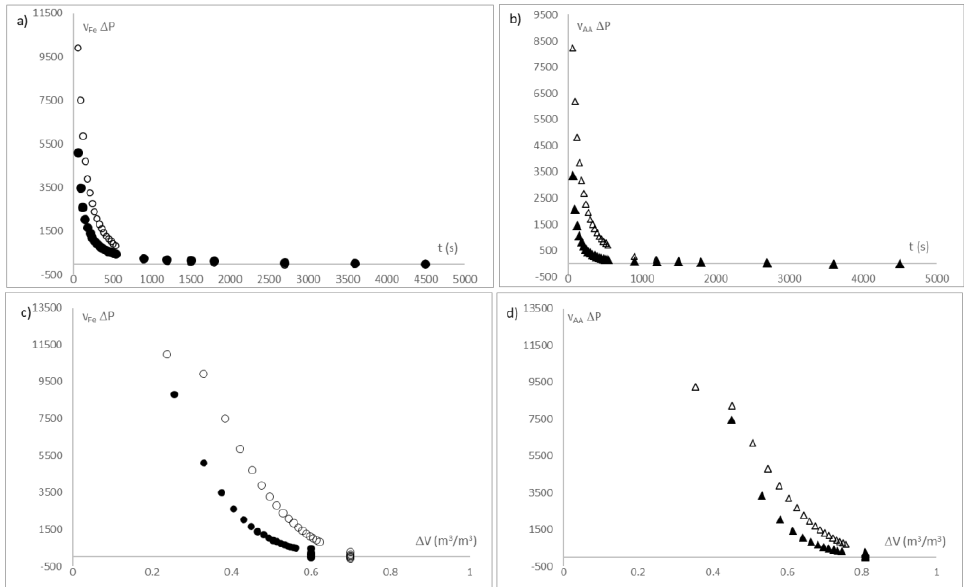
Figure 13. ( a , b ) represents the evolution of the mechanical gradient of ( a ) the iron ion beads and ( b ) the ascorbic acid beads at 3 and 4.7 pH; ( b , c ) is the relationship between the mechanical gradient and volume variation of ( c ) the iron ion beads and ( d ) the ascorbic acid beads at 3 and 4.7 pH. Where (●) is iron ion released at pH of 3; ( ○) is iron ion released at pH of 4.7; ( ▲) is ascorbic acid released at pH of 3 and ( ∆) is ascorbic acid released at pH of 4.7.